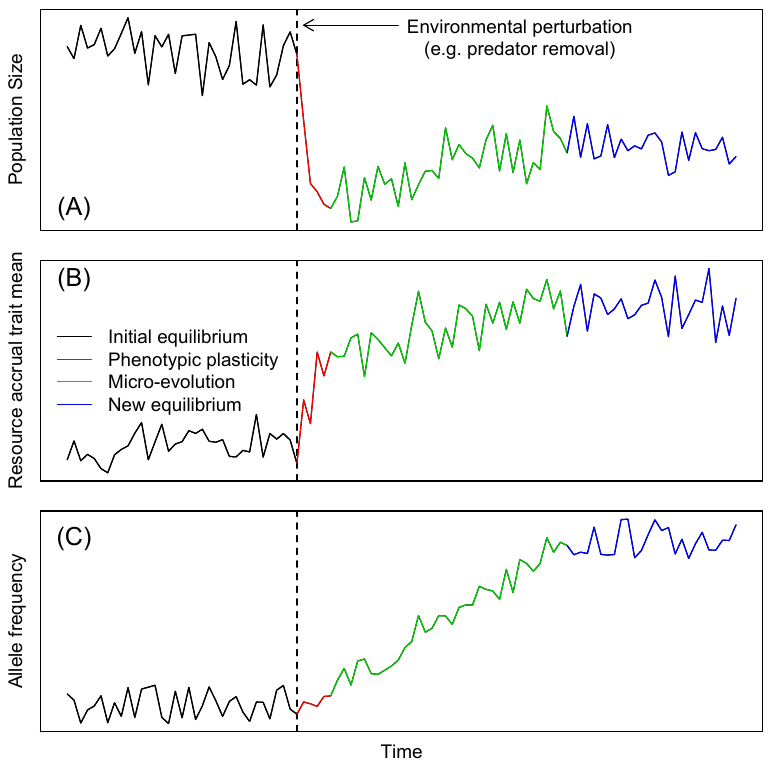
Figure 1. The (A) population, (B) phenotypic trait, and (C) micro-evolutionary dynamics of populations as they move from one stationary state to another. At ecological and evolutionary equilibrium, there are no temporal trends in population size, phenotypic trait distributions, or allele frequencies (black lines). Following an environmental perturbation (dotted vertical line) ecological and evolutionary change occurs (red and green lines) until a new stationary state is achieved (blue lines). In this example, population size changes quickly following the perturbation, while phenotypic and evolutionary changes occur more slowly. There will be a period when phenotypic plasticity is likely stronger than microevolution, which is reflected in quite rapid phenotypic change (B). Evolution occurs more slowly, resulting in gradual change in population size, the mean of phenotypic traits, and allele frequencies. I have given an example of ecological and evolutionary change in a single population, but similar patterns will be observed in other species within the